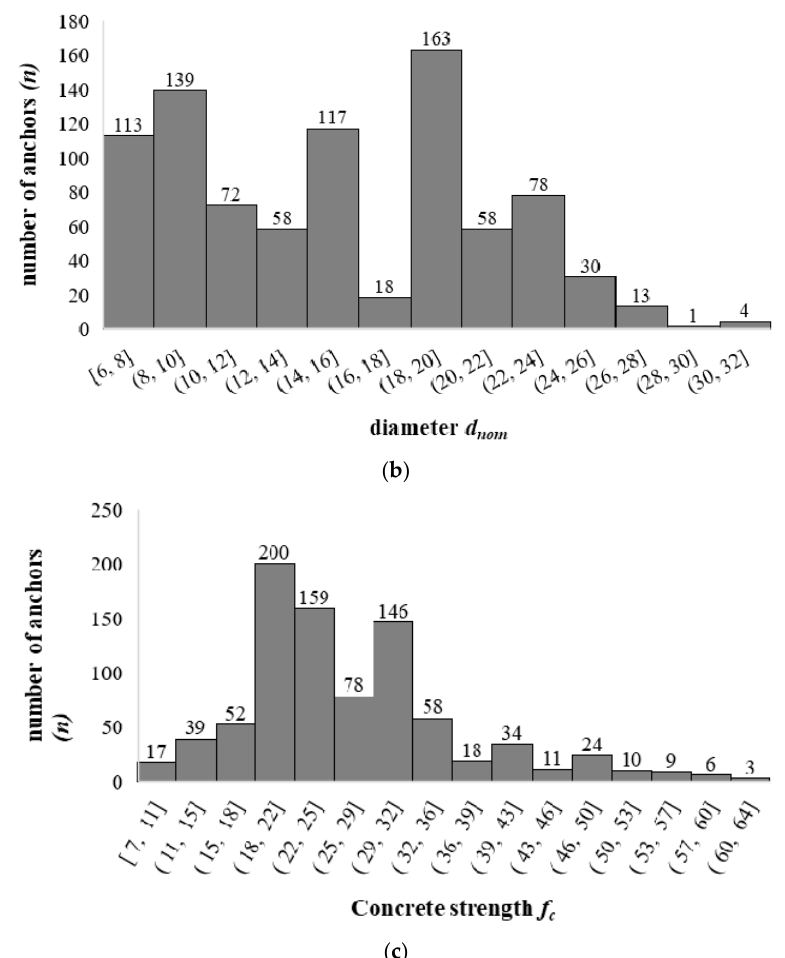
Figure 3. Histograms of the data representation. ( a ) Embedment depth; ( b ) Anchor diameter; ( c ) Concrete strength.